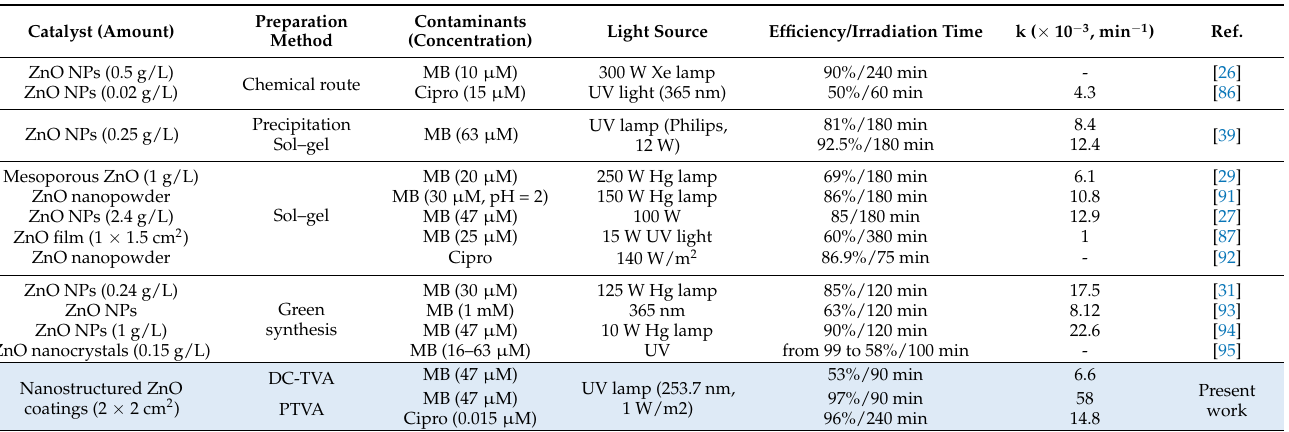
Table 1. Comparative data of photocatalytic degradation of MB dye and antibiotic using ZnO- based